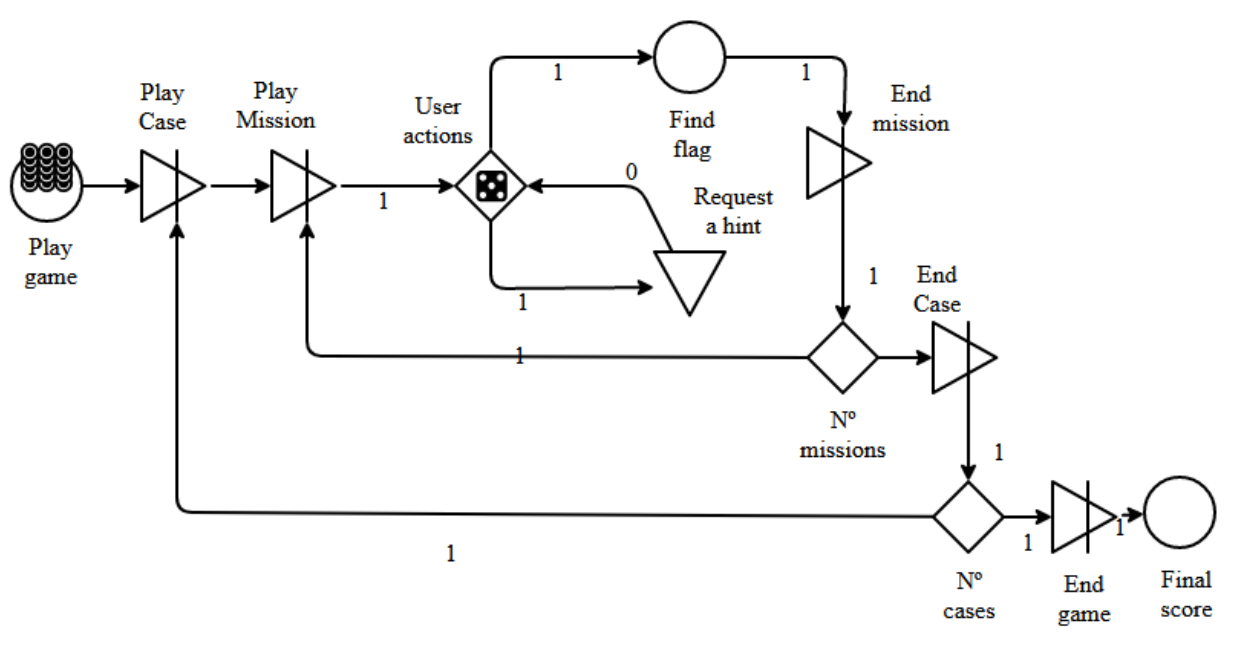
Figure 2. Game pattern diagram using Machinations